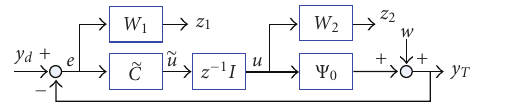
Figure 3: Block diagram with the controller (cid:17) C ( z ) and the delay z − 1 I